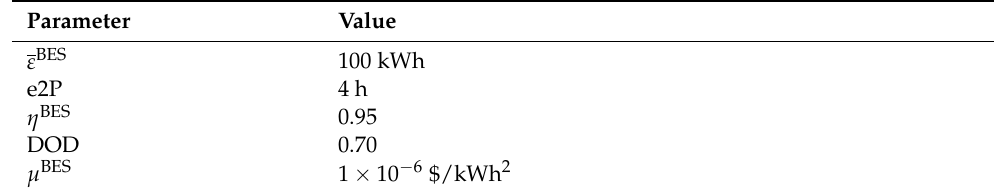
Table 5. BES data Table 5. BES data [26,27].